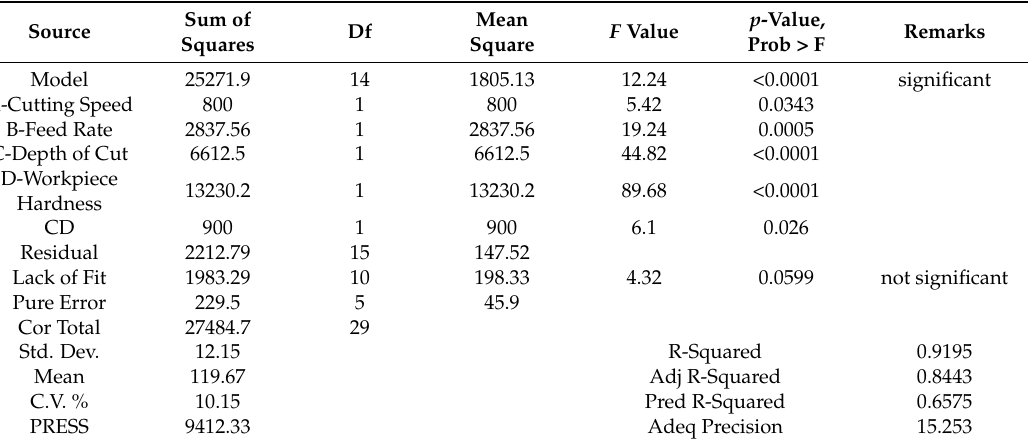
Table 12. Model of Thrust Force for CBN-II